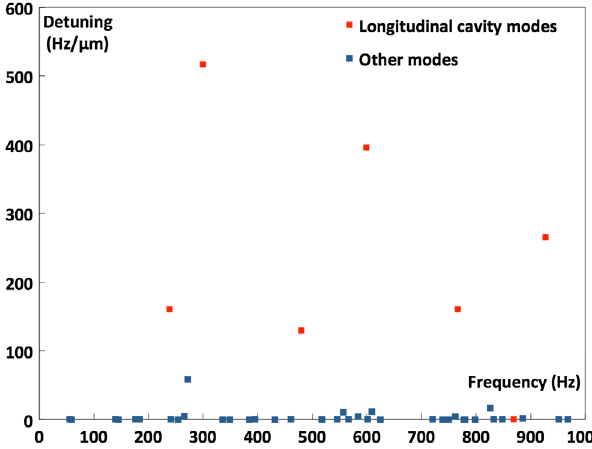
FIG. 6. Cavity detuning normalized to the maximum structural displacement as a function of the mechanical eigenmode fre- quency. Longitudinal cavity modes are highlighted in red.